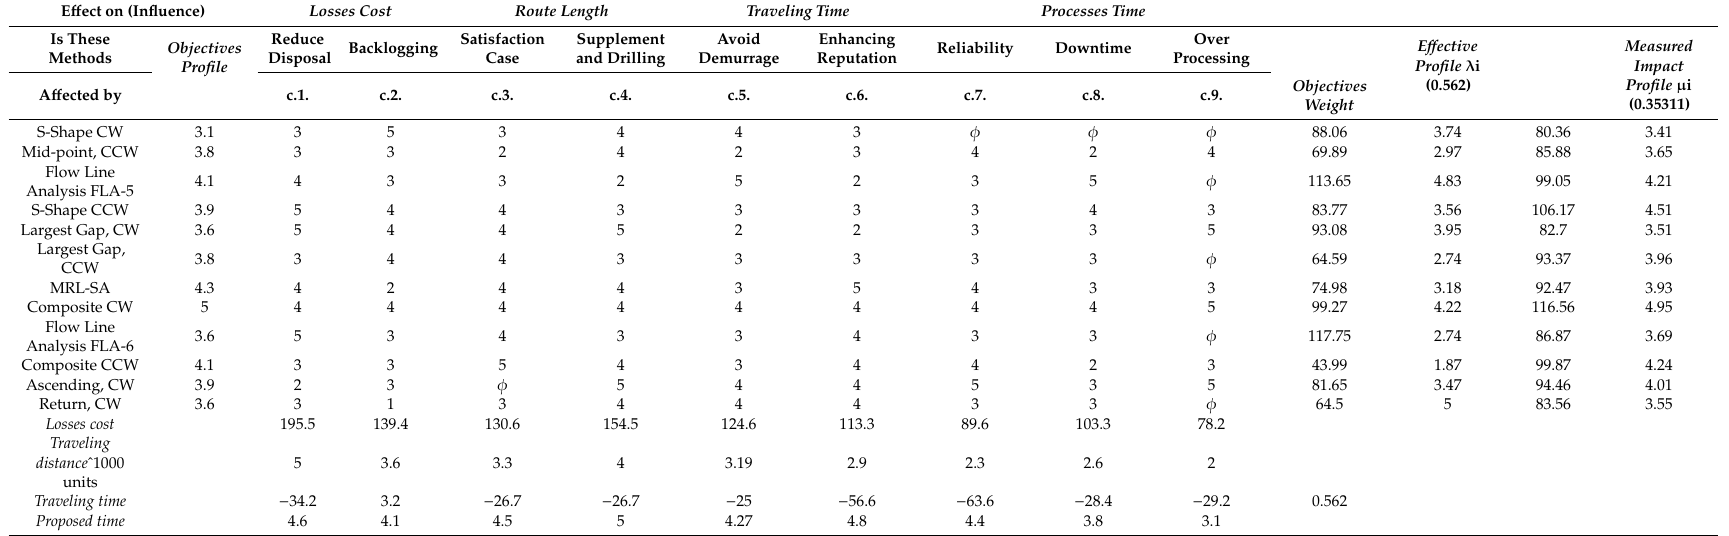
Table 4. The impact factors of measurement objectives.